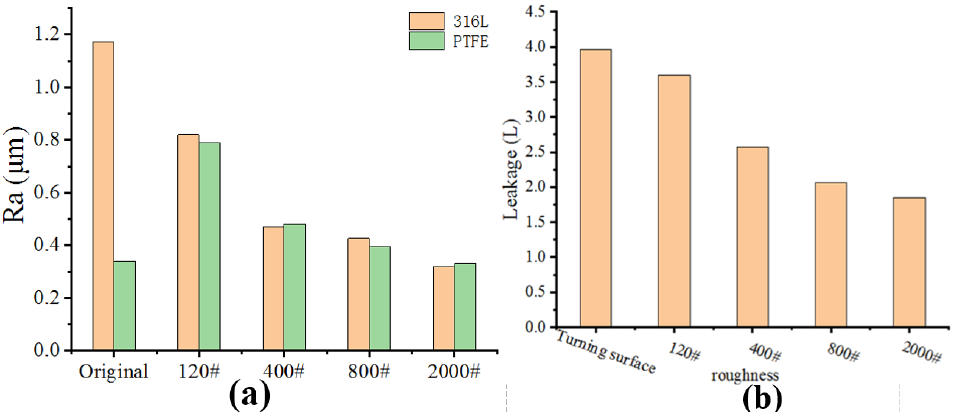
Figure 14. ( a ) The average roughness ( R a ) of 316L–PTFE friction pairs after friction experiments; ( b ) the leakages of 316L–PTFE friction pairs with different interface roughness.